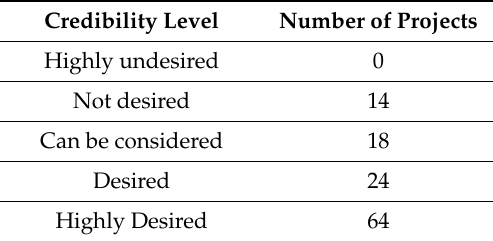
Table 11. Statistical analysis of credibility assessment of delivered projects (Total projects =